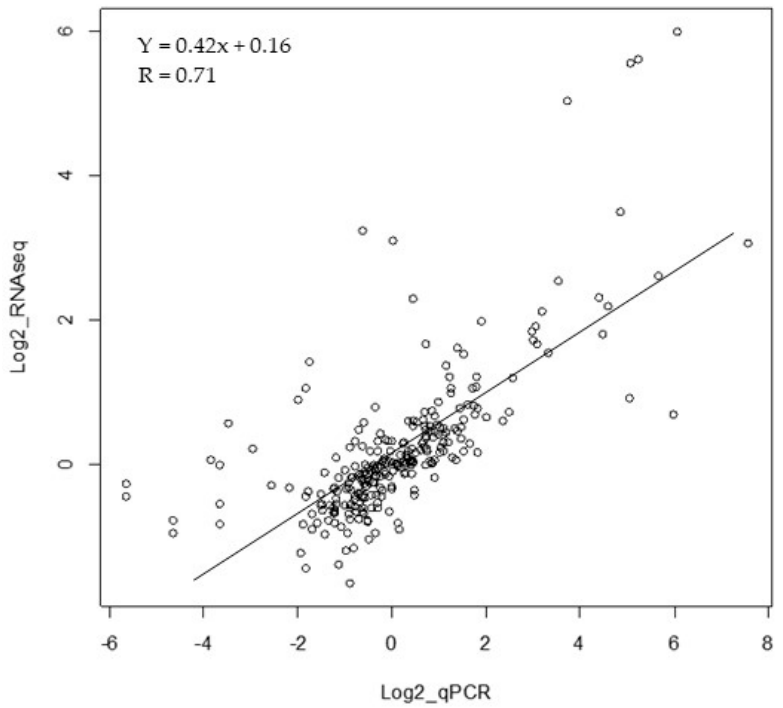
Figure 2. Scatter plot between the two sets of transcripts issued from the present RNA-seq and qPCR data from Reference [28]. The x-axis corresponds to log2 of qPCR ratios and the y-axis shows log2 of RNA-seq ratios for 33 transcripts. The linear relationship between the 2 variables and their correlation coefficient, R = ∑ xy / √ ∑ x 2 ∑ y 2 are reported in the top of the graph.